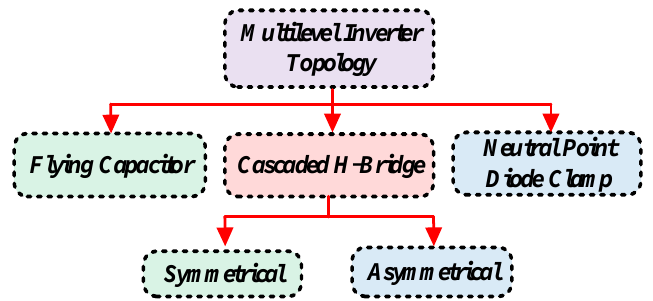
Figure 1. Classification of multilevel inverter topology.